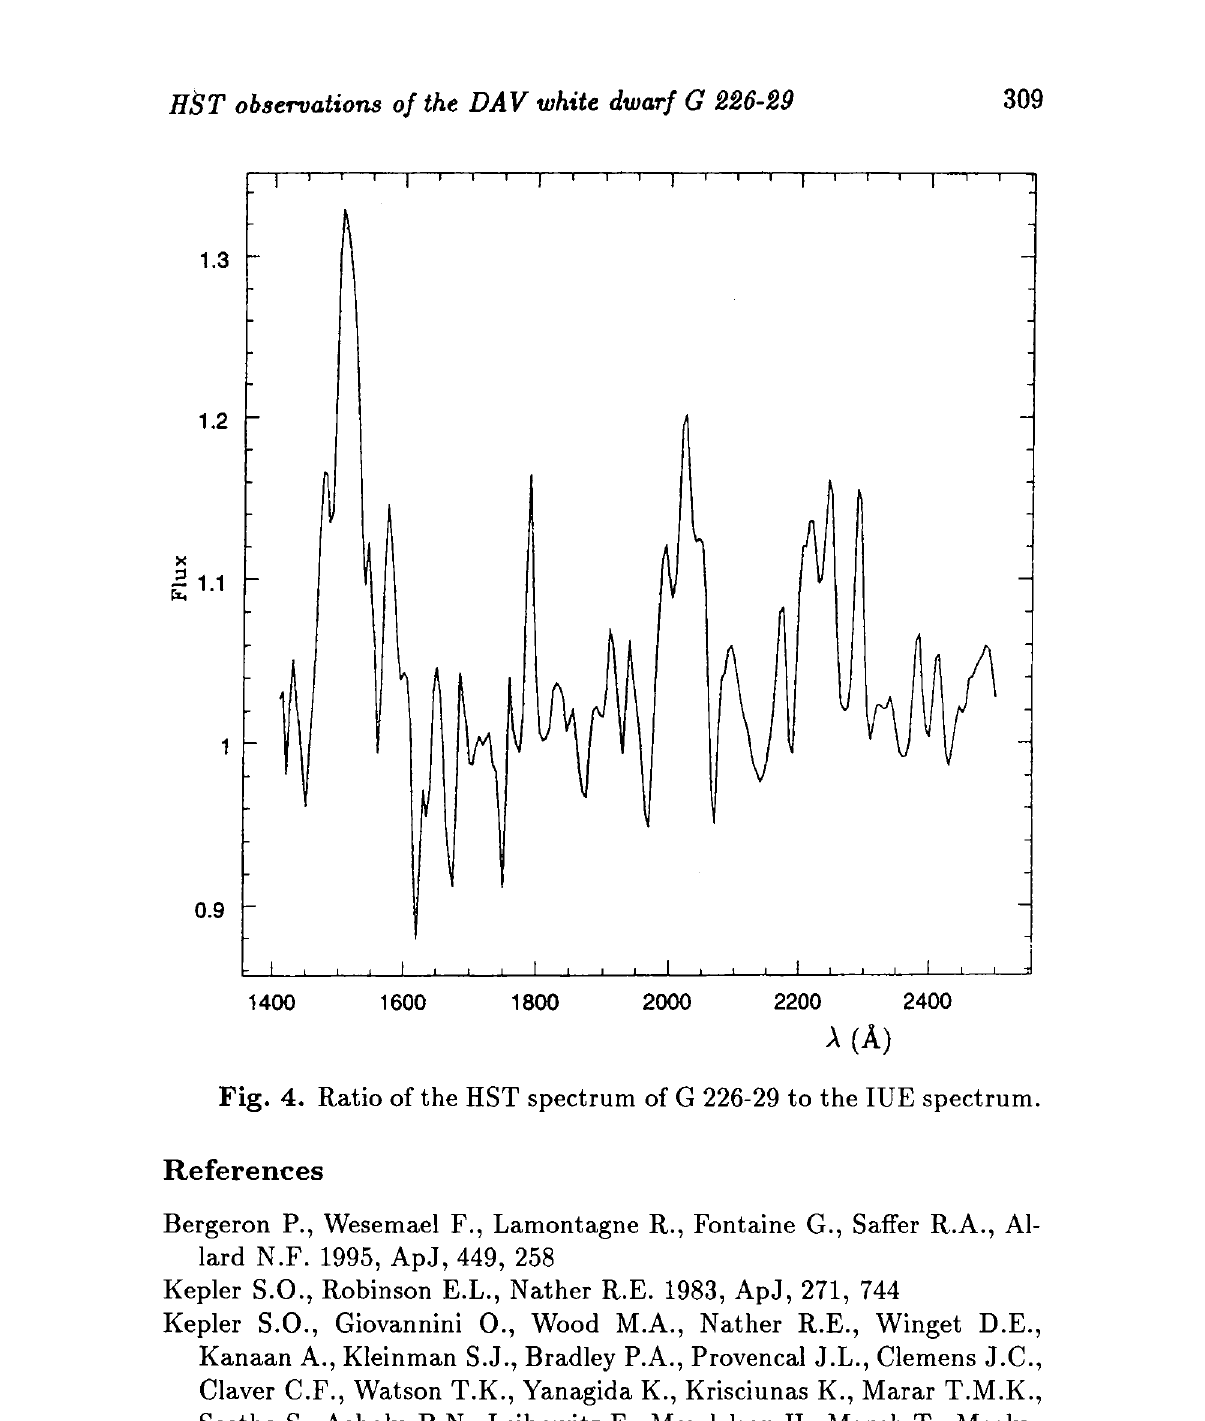
Fig. 4. Ratio of the HST spectrum of G 226-29 to the IUE